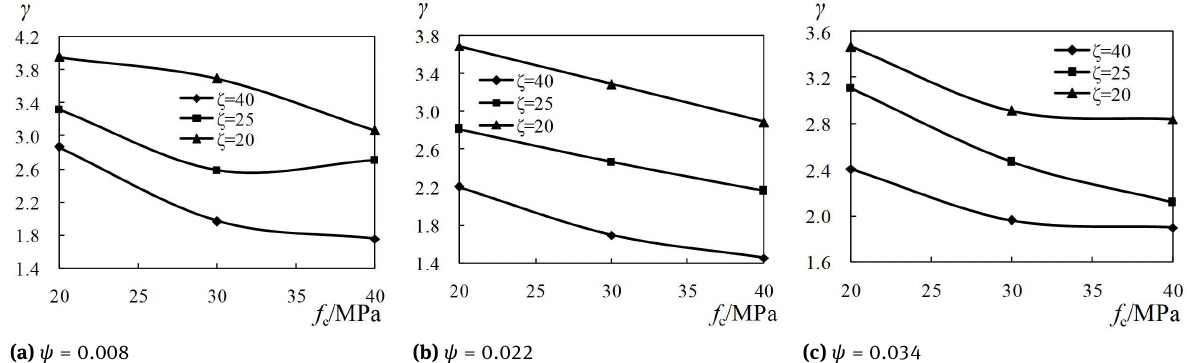
Figure 18: Confinement coeflcient versus nano-silica concrete strength